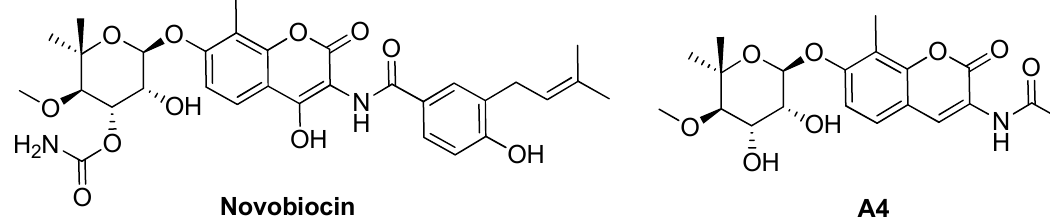
Figure 9. Chemical structures of Hsp90 inhibitors binding the C-terminal domain.